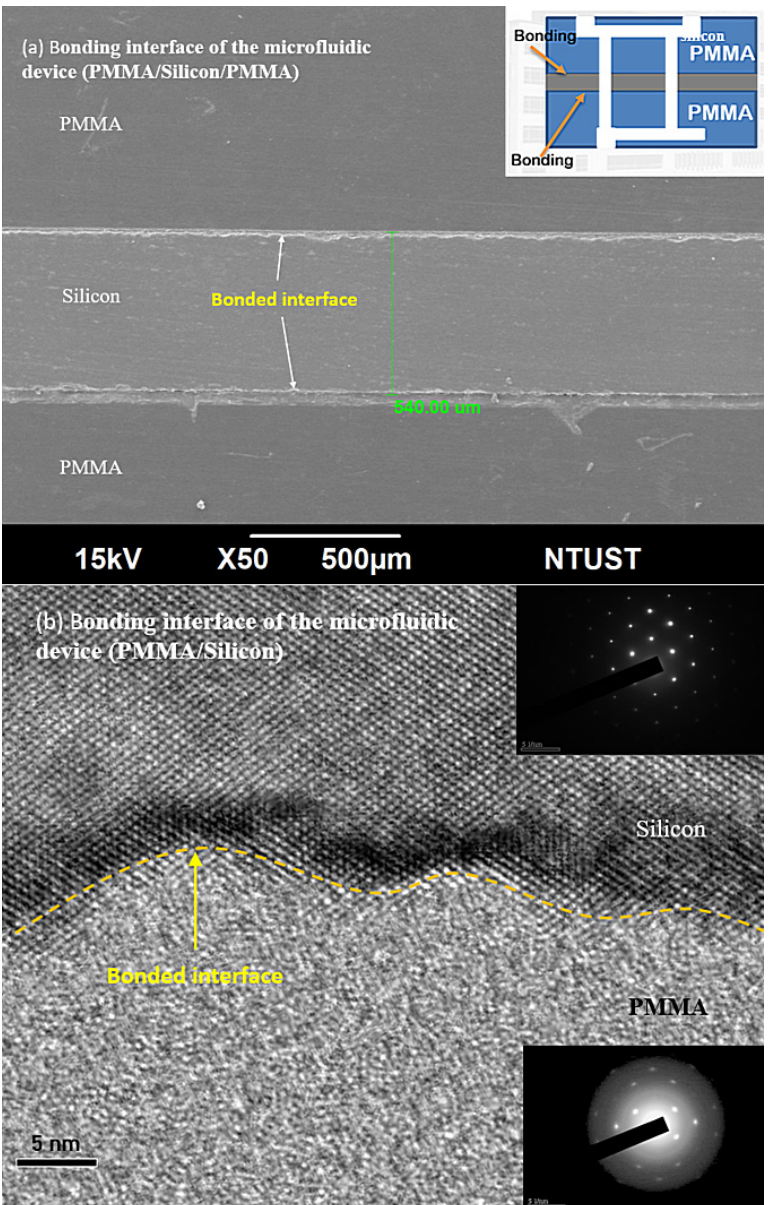
Figure 11. ( a ) Lossless bonded interface of the microfluidic device (PMMA/silicon/PMMA). ( b ) HR-TEM image of the bonded interface with diffraction patterns. ( b ) HR-TEM image of the bonded interface with diffraction